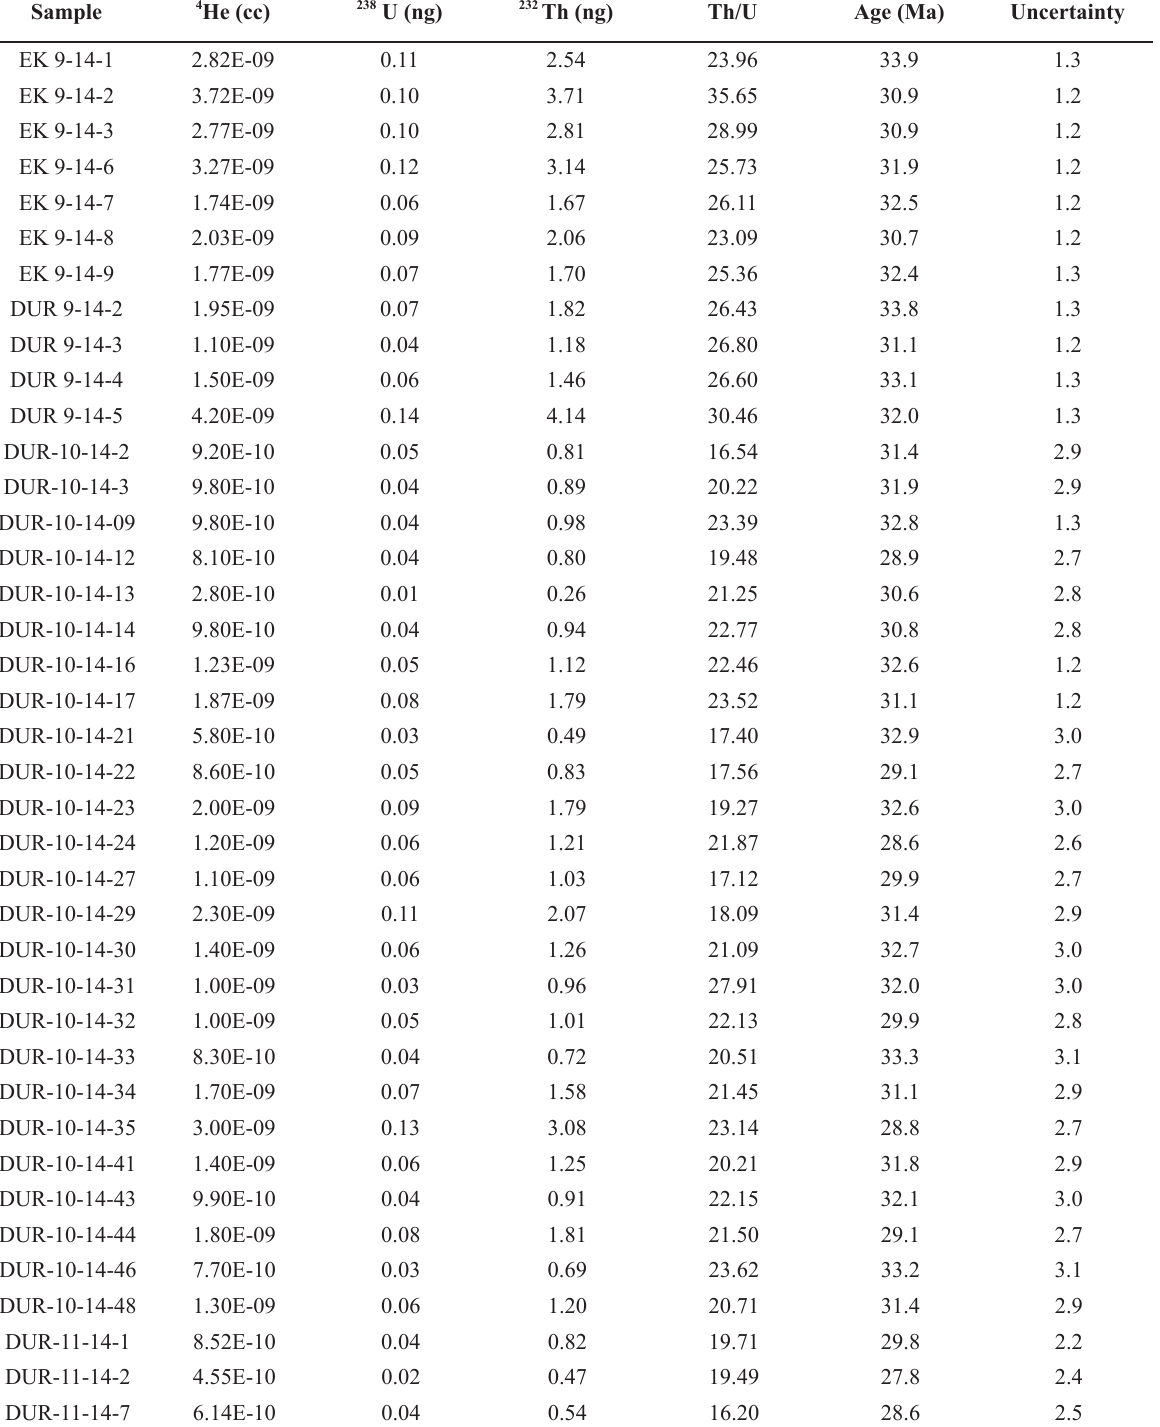
He, U and Th data for Durango fluorapatite reference material from UK (EK) and DUR UNESP (RC) (U+Th)/He thermochronology laboratory at UNESP Rio